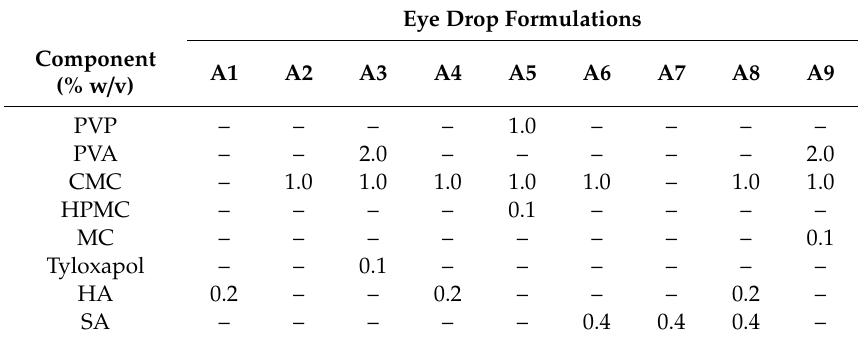
Table 2. Polymers used to prepare nepafenac eye drop formulations and their